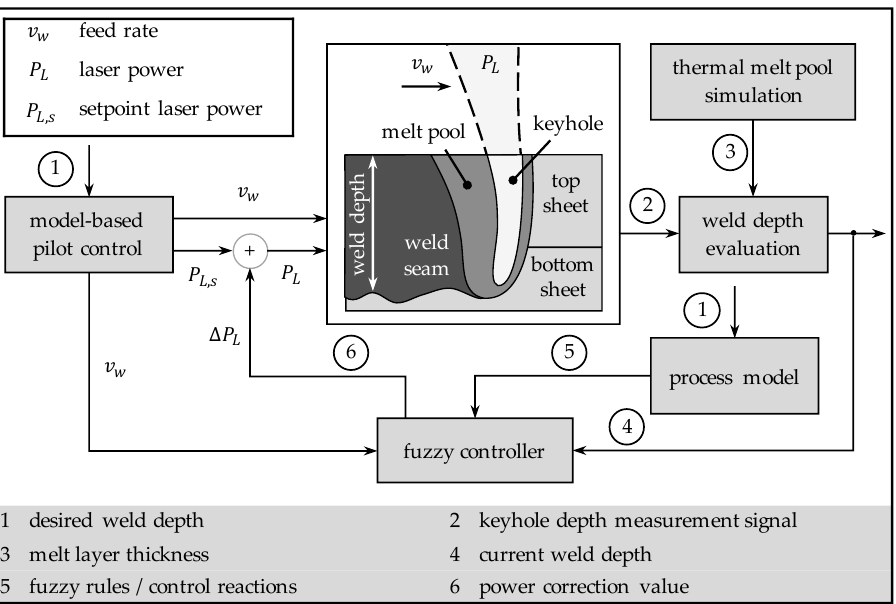
Figure 7. Structure of the weld depth control loop.